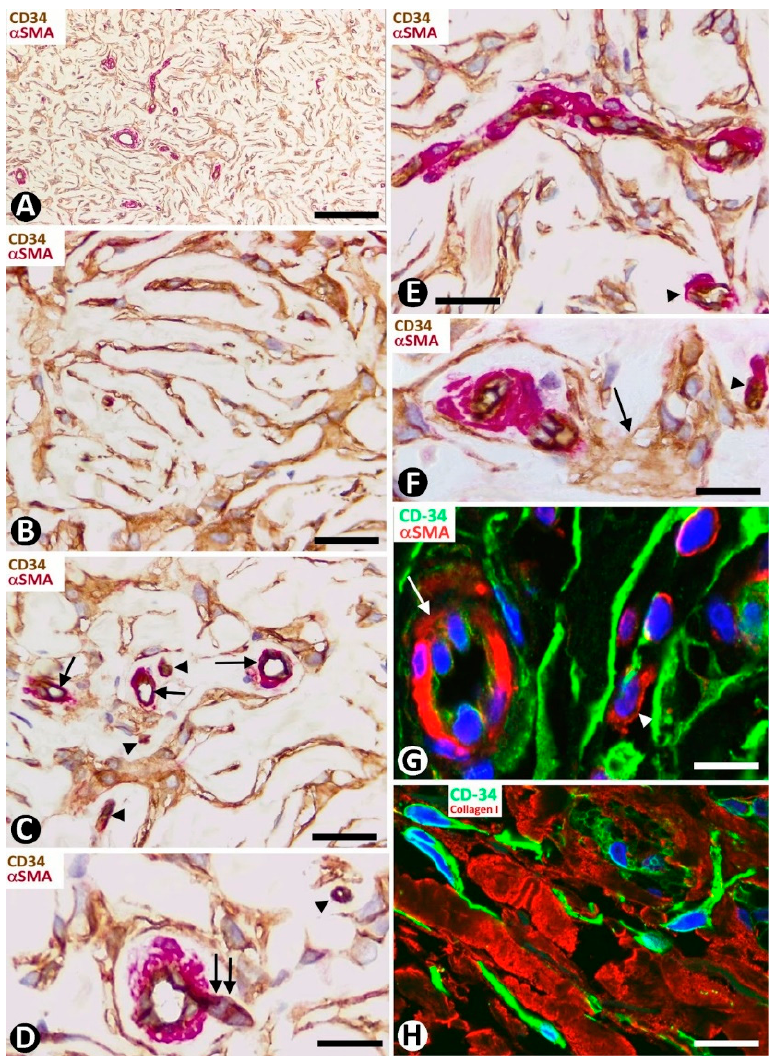
Figure 13. CD34+ stromal cells in sclerotic fibroma (circumscribed storiform collagenoma). ( A – F ) Double immunochemistry for CD34 (brown) and α SMA (red). Hematoxylin counterstain. ( G , H ) Double immunofluorescence labelling for CD34 (green) and α SMA (G, red) and Collagen I ( H , red). DAPI counterstain. ( A ) Voluminous CD34+ stromal cells with a whorled (storiform) arrangement are observed around vessels. ( B ) Occasional lamellar arrangement of the CD34+ stromal cells resembling a cutaneous sensory corpuscle. ( C – F ) Vessels (arrows in C-E and arrowheads) at the centre of the cluster of CD34+ stromal cells that form whorls. Note that some vessels are thin, with a virtual lumen (arrowheads), present sprouting endothelial cells ( D , double arrow), pass from one whorled structure to another ( E ) and show some perivascular multinucleated CD34+ stromal cells ( F , arrow). ( G , H ) CD34+ stromal cells (green) around a vessel (mural cells: red, arrow) ( G ) and collagen I (red) ( H ). Bar: ( A ) 150 µm, ( B – H ) 25 µm.